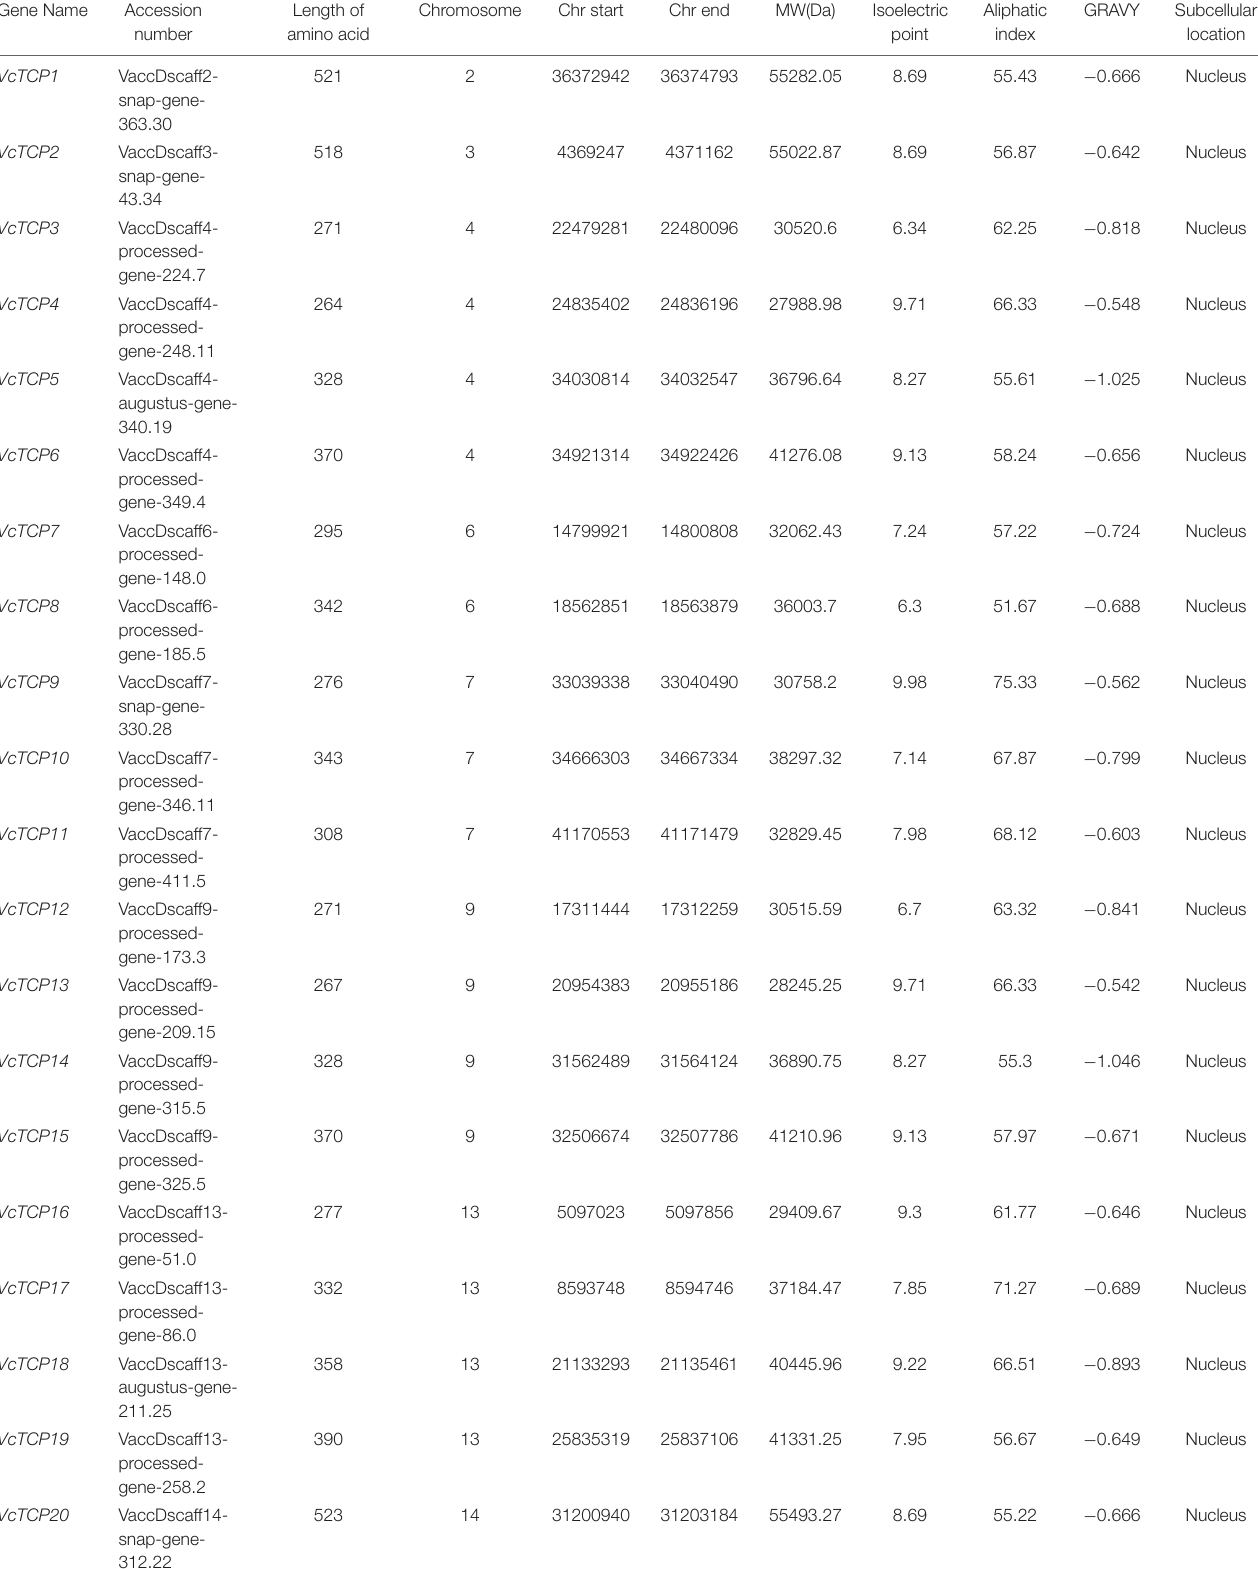
TABLE 3 | Basic information of the TCP gene family in